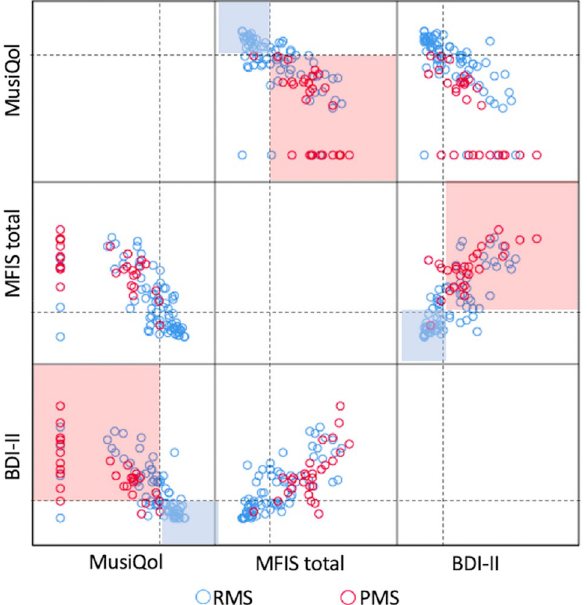
Figure 1. Cohort distribution based on MusiQoL, MFIS and BDI-II values and MS phenotype. A bidimensional correlation matrix shows the relationship between the PRO investigated and the distribution of pwPMS (red empty dots) and pwRMS (blue empty dots). Dashed lines represent the median values for the pwRMS cohort. Note that in each 2 × 2 graph, patients tend to distribute in two squares, the shaded in blue, were pwRMS and favorable results in the scales concentrate, and the shaded in red were pwPMS are mostly confined, corresponding to less favorable PRO scores. Interestingly, although none of the pwPMS are in the blue squares, there are several pwRMS that are included in the red squares, suggesting that these patients could be misclassified or behave differently. Abbreviations: PMS: progressive multiple sclerosis; RMS: relapsing multiple